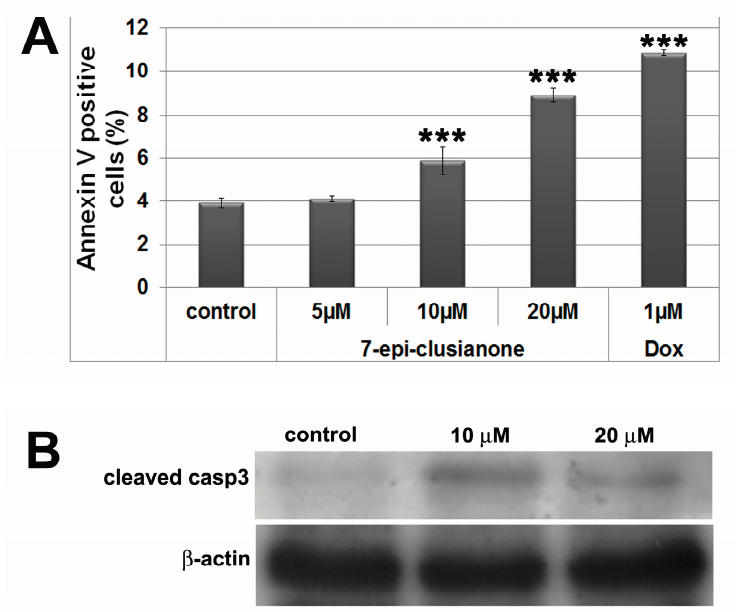
Figure 3 . ( A ) Cell death evaluated by Annexin V assay; doxorubicin was used as a